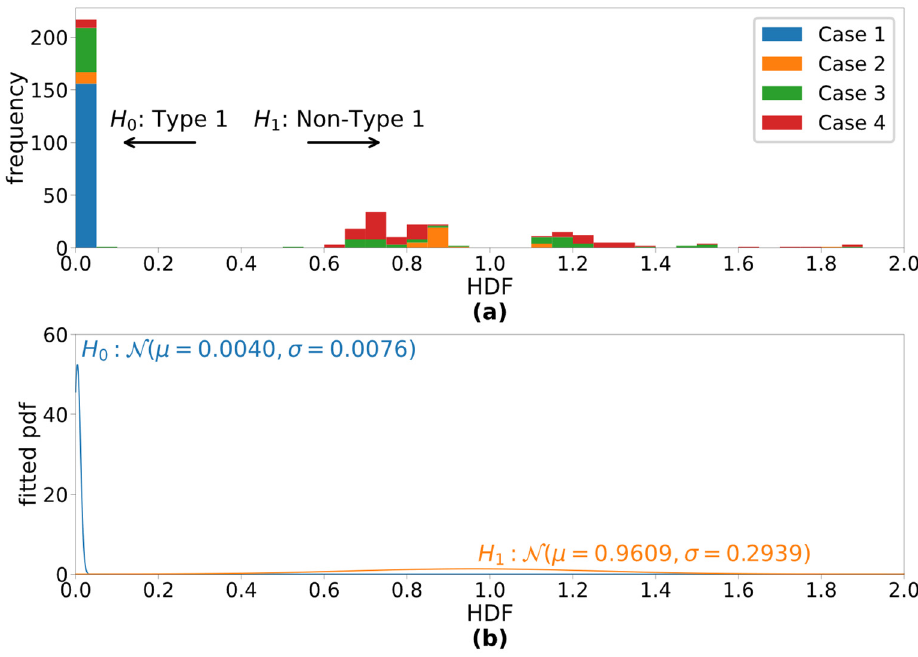
Figure 3. ( a ) Histogram of the HDF values of all four cases and ( b ) fitted conditional normal pdfs for Type-I signals ( 𝐻 (cid:2868) ) and non-Type-I signals ( 𝐻 (cid:2869) ).